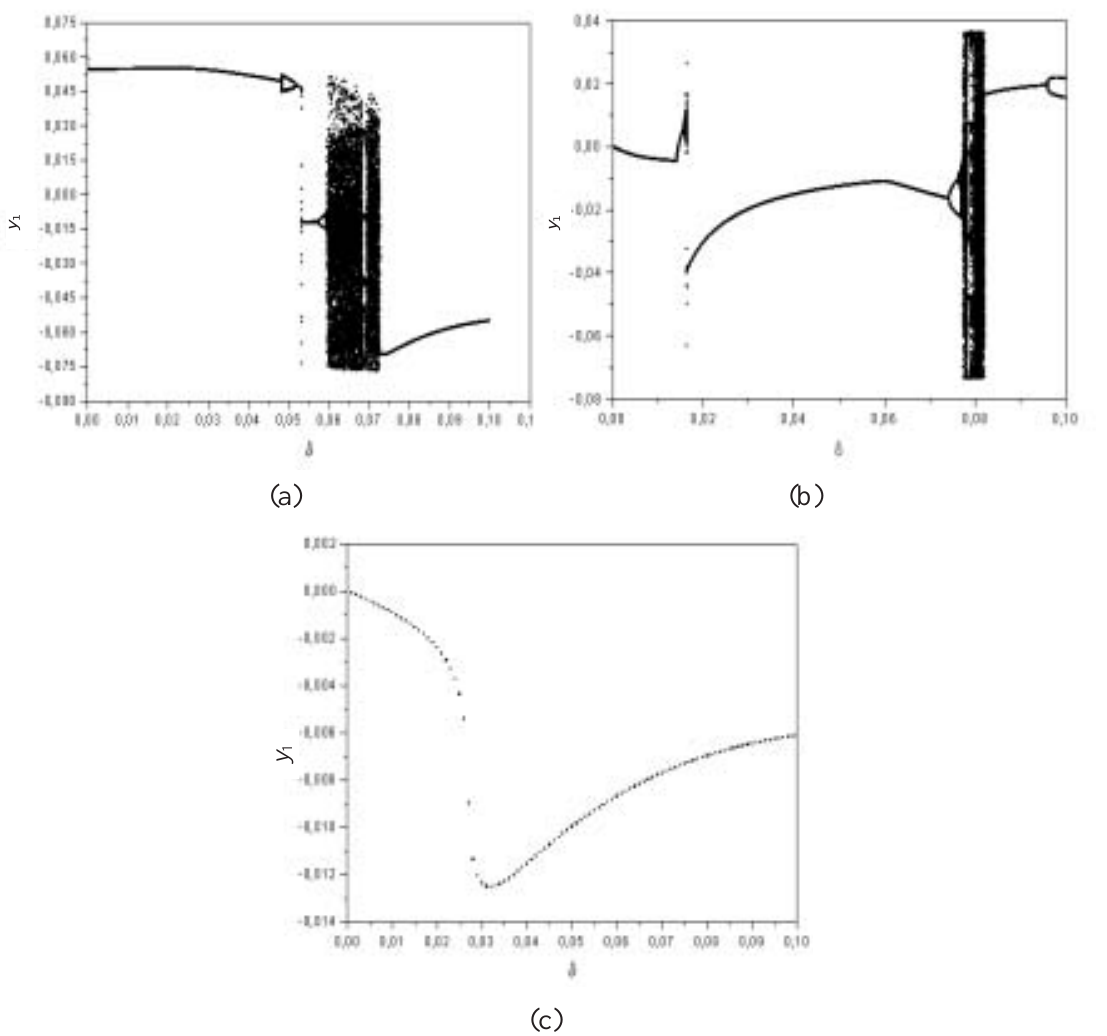
Fig. 2. Bifurcation diagrams varying parameter δ . (a) θ = 0 . 7 ; (b) θ = 1 . 5 ; (c) θ = 3 . 5 .